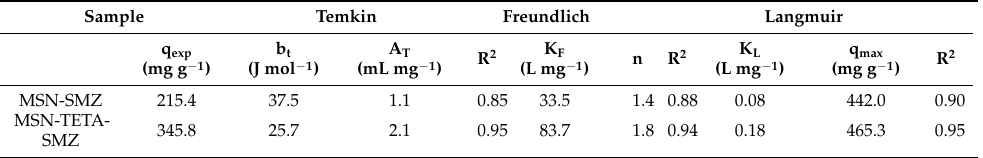
Table 3. Adsorption isotherm parameters for SMZ on MSN and MSN-TETA.